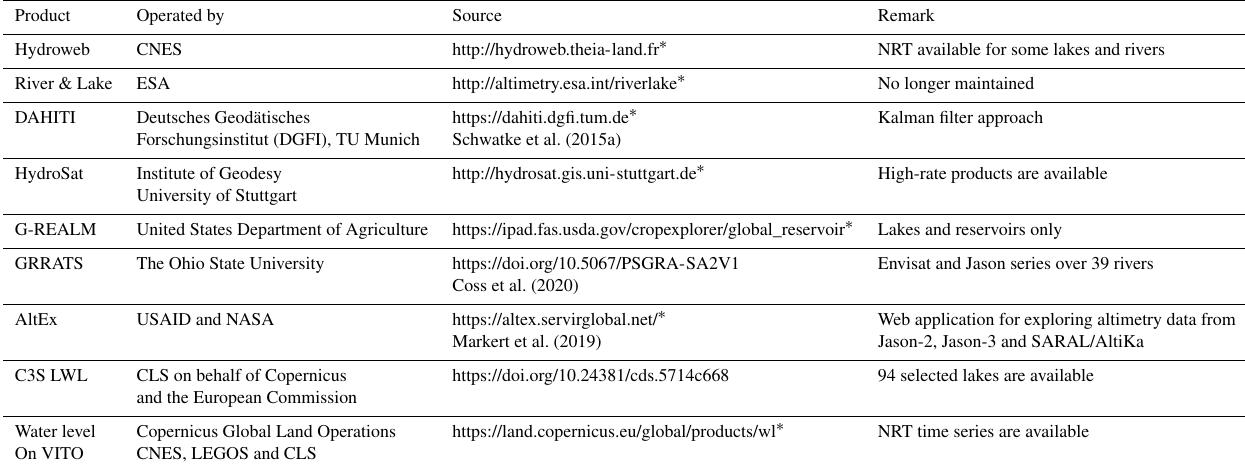
Table 1. Providers of water level time series from satellite